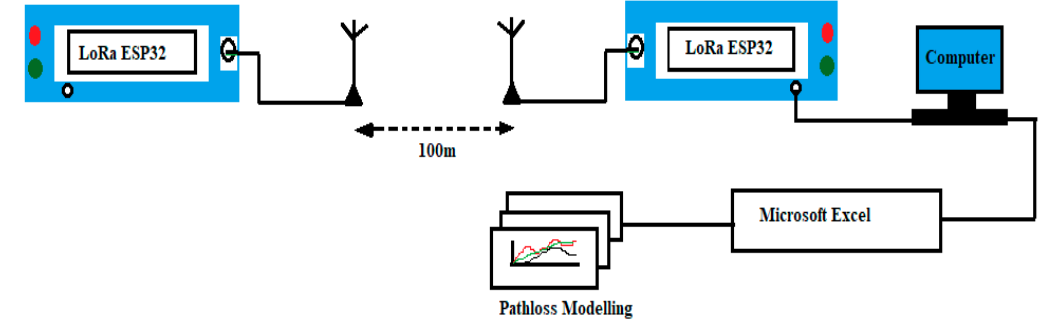
Figure 4. Measurement and modeling process diagram.